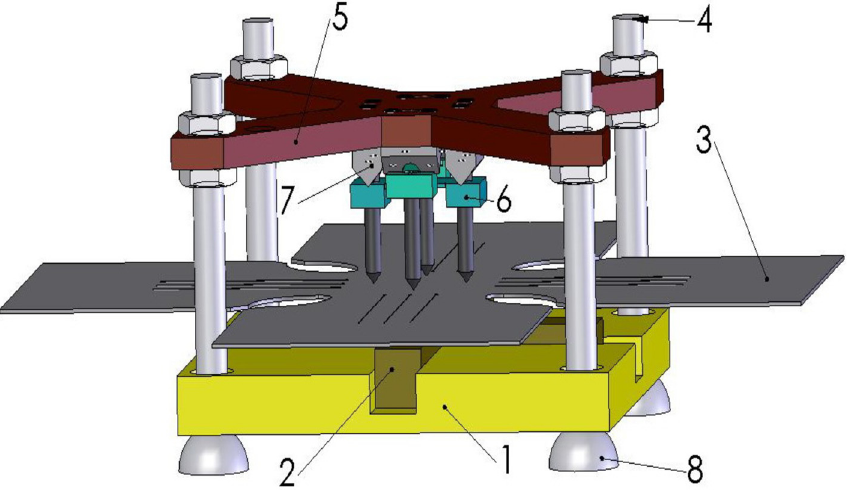
Figure 4. Clamping the cruciform specimen in the jaws.